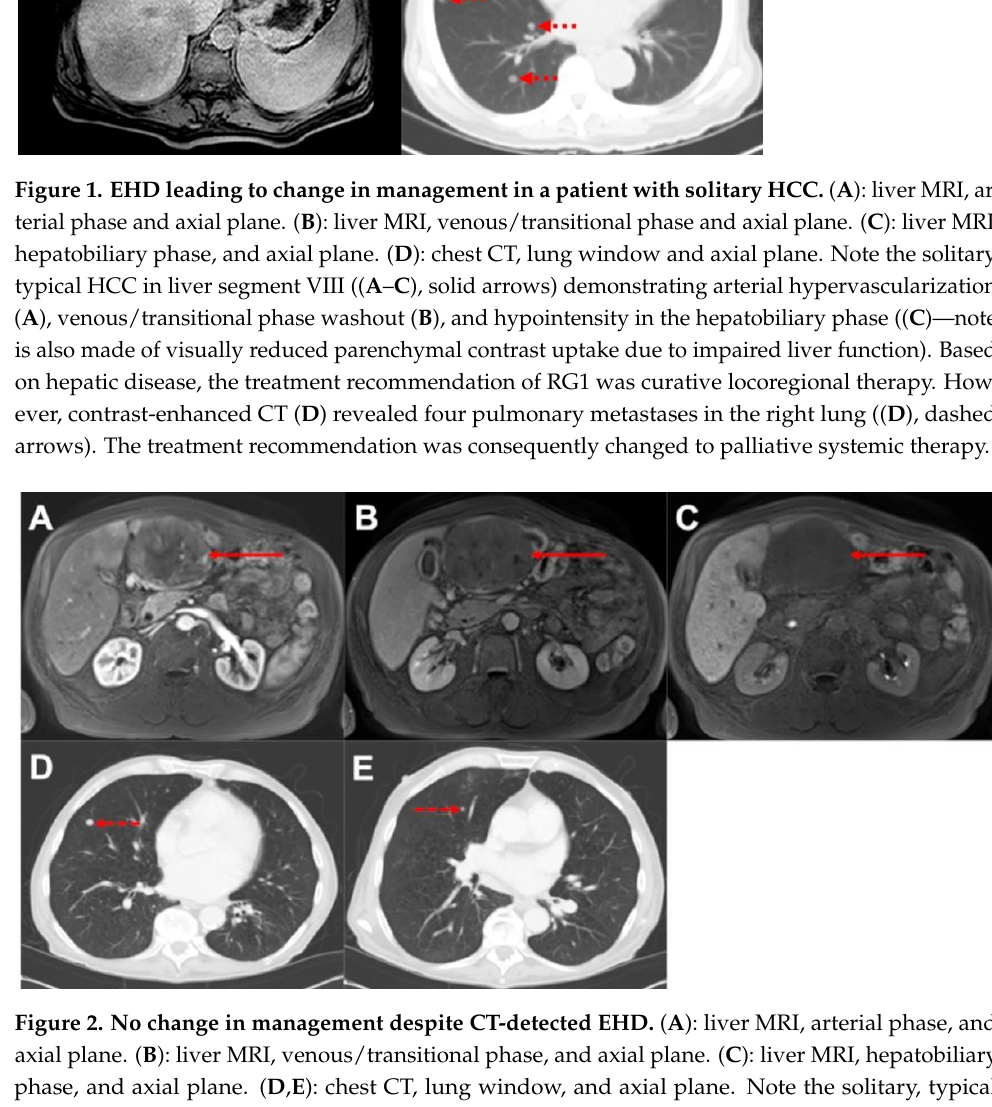
Figure 2. No change in management despite CT-detected EHD. ( A ): liver MRI, arterial phase, and axial plane. ( B ): liver MRI, venous/transitional phase, and axial plane. ( C ): liver MRI, hepatobiliary phase, and axial plane. ( D , E ): chest CT, lung window, and axial plane. Note the solitary, typical HCC in liver segment III (( A – C ), solid arrows) demonstrating arterial hypervascularization ( A ), portalvenous phase washout ( B ), and hypointensity in the hepatobiliary phase ( C ). CT showed two additional pulmonary metastases in the right lung (( D , E ), dashed arrows). However, EHD did not lead to a change of the therapy recommendation, as palliative treatment was already recommended due to close proximity of the primary tumor to central vascular